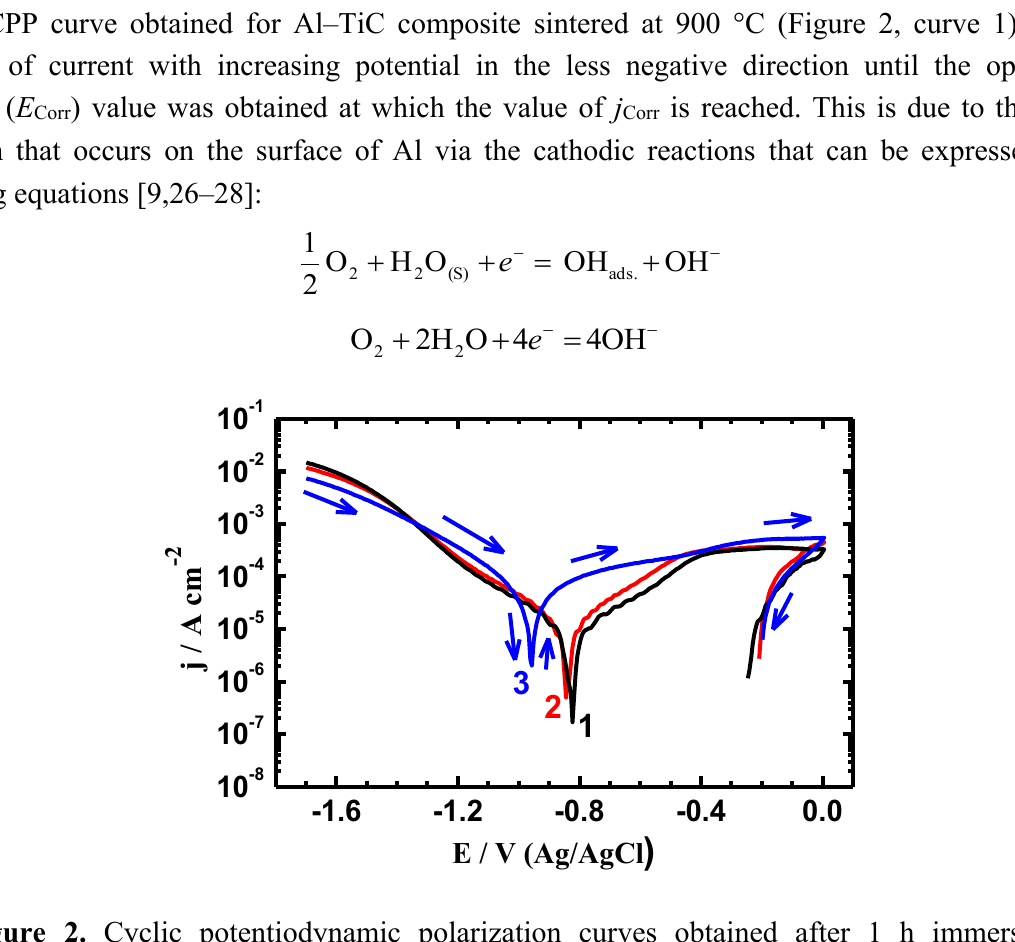
Figure 2. Cyclic potentiodynamic polarization curves obtained after 1 h immersion in 3.5% NaCl solutions for the Al–TiC composite sintered at ( 1 ) 900, ( 2 ) 1100, and ( 3 ) 1300 °C,